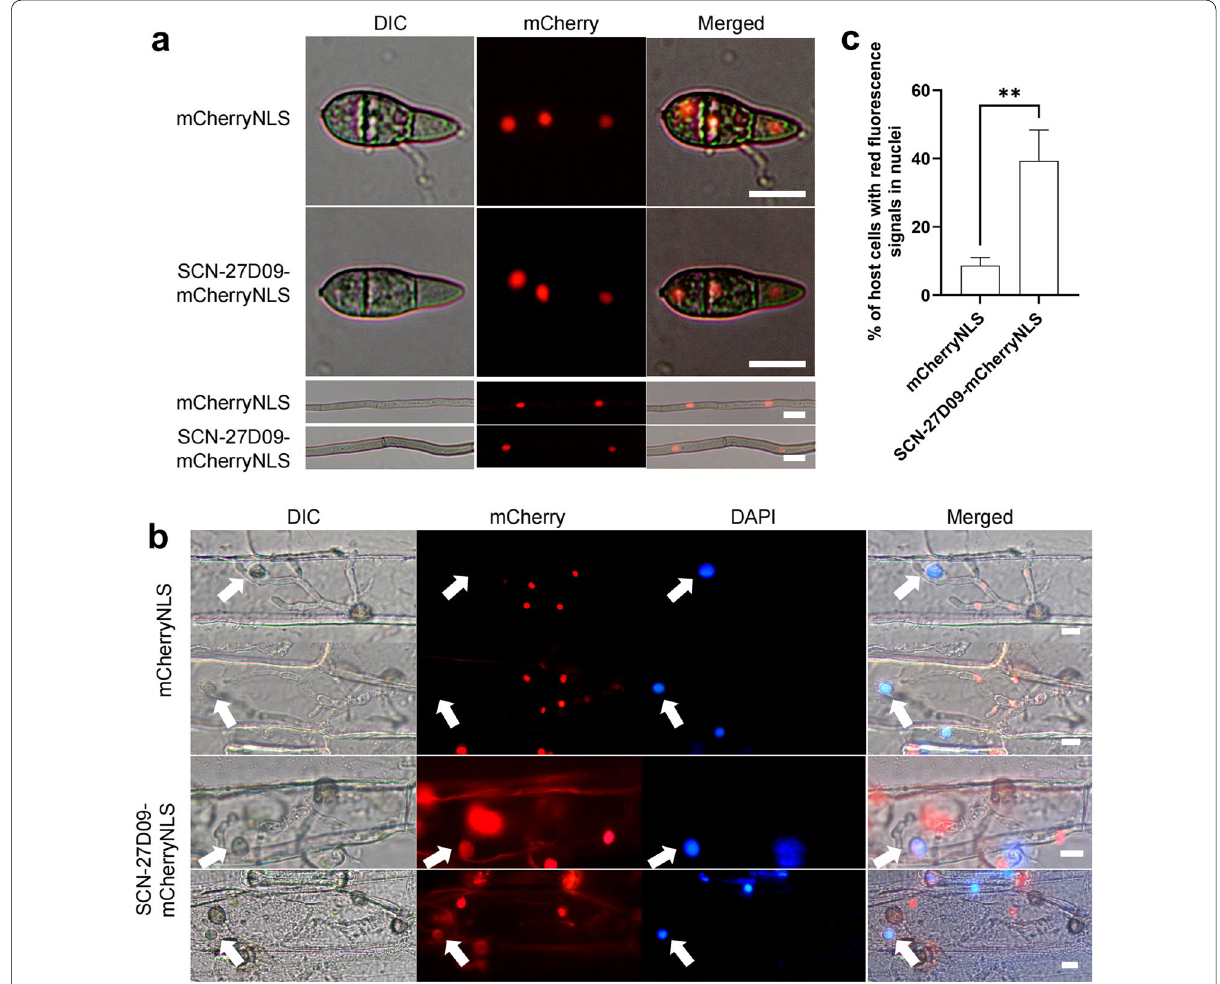
Fig. 2 SCN-27D09 can be secreted into host cells. a Fluorescence signals observed in conidia and hyphae of Magnaporthe oryzae transformants expressing mCherryNLS and SCN-27D09-mCherryNLS. Bar 10 µm. Red fluorescence was observed in the nuclei of conidia and hyphae. b Nuclear = localization of red fluorescent signals in epidermal cells of barley leaves infected with M. oryzae transformants expressing SCN-27D09-mCherryNLS but not mCherryNLS at 27 h post-inoculation (hpi). The white arrows point to the barley nuclei. Bar 10 µm. c The percentage of M. oryzae -infected = barley epidemic cells with red fluorescent signals accumulated in the nuclei. At least 50 M. oryzae -infected barley epidemic cells were measured for the strains expressing SCN-27D09-mCherryNLS or mCherryNLS. ** P <